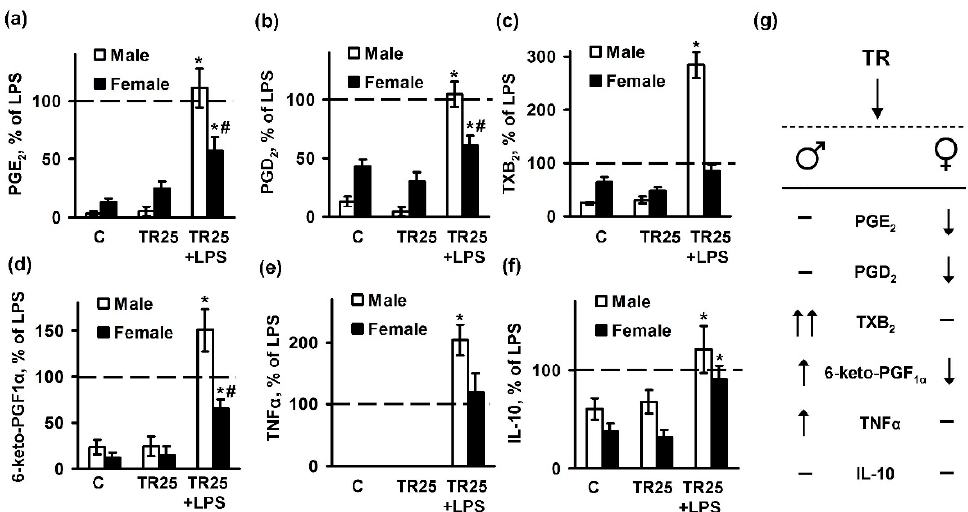
Figure 4. Trilostane differentially affects acute inflammatory responses in male and female astrocytes. Astrocytes were pretreated for 0.5 h with trilostane (TR; 25 µ M) and then stimulated with LPS for 4 h. ( a – d ) Concentrations of prostaglandins in the supernatants were measured using UPLC-MS/MS; ( e , f ) Changes in the TNF α and IL-10 release levels in cell supernatants were measured using ELISA; ( g ) A scheme summarizing the differences in synthesis of prostaglandins, and the release of TNF α and IL-10 in male and female astrocytes upon LPS challenges ( ↑ : increased release, ↑↑ : strongly increased release, ↓ : decreased release, –: no effect). All of the data are represented as ratios to LPS treatment (LPS treatment was accepted as 100%). White bars indicate the male culture, black bars indicate the female culture. Values are represented as mean ± SEM from three independent experiments performed in triplicate. * p < 0.05 compared with unstimulated cells, # p < 0.05 compared with indicated bars (sex difference).